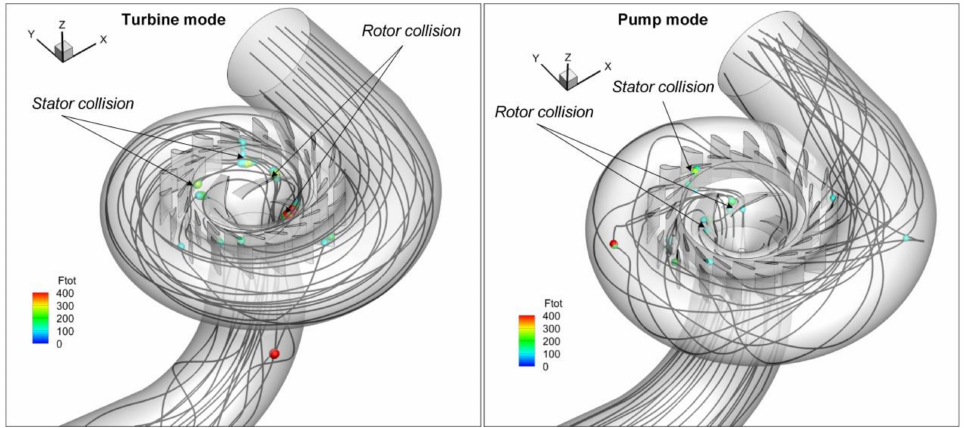
Figure 11. Trajectories and observed collisions of fish for different starting positions, at turbine mode ( left ) and pumping mode ( right